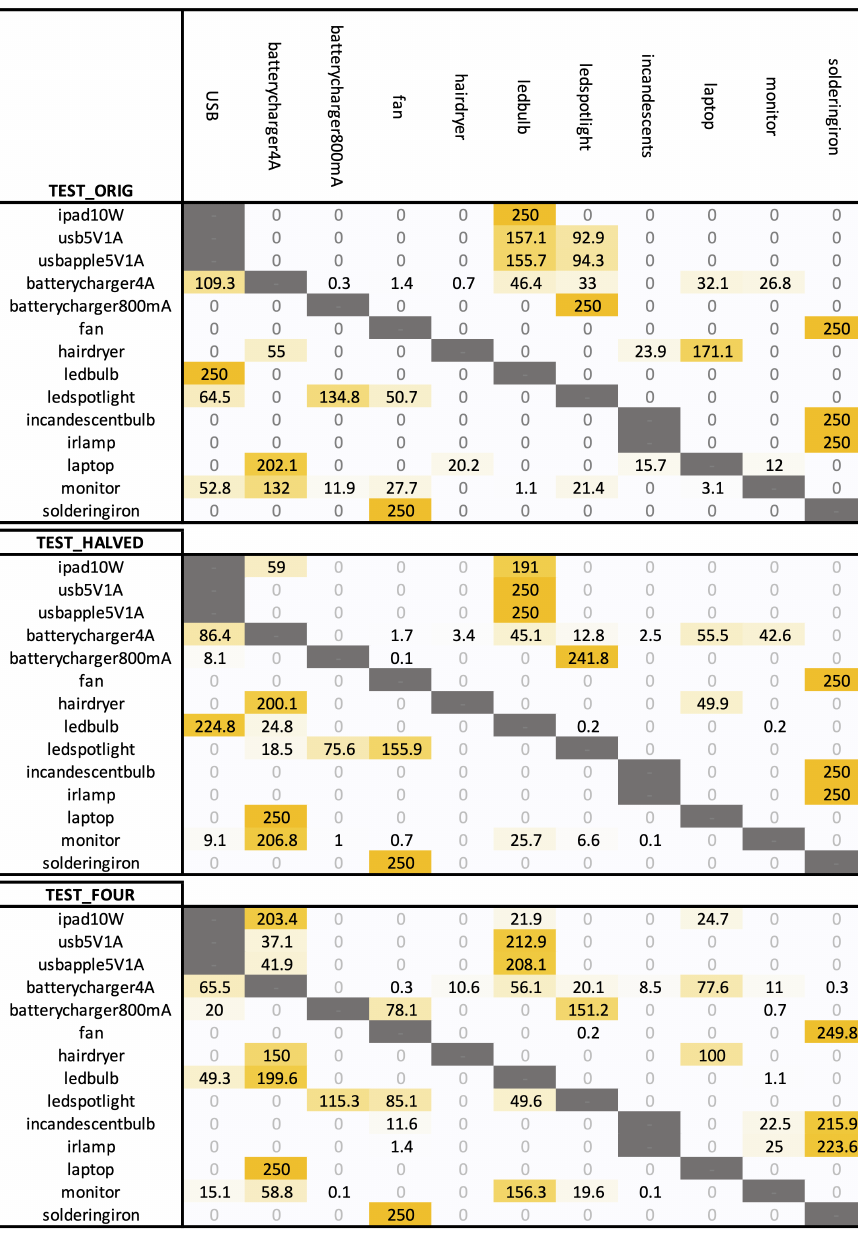
Figure 3. Classification of unknown electrical loads (left column) to the other classes with the CNN model. Each row shows (the average of 10 runs) where the CNN model would classify the unknown